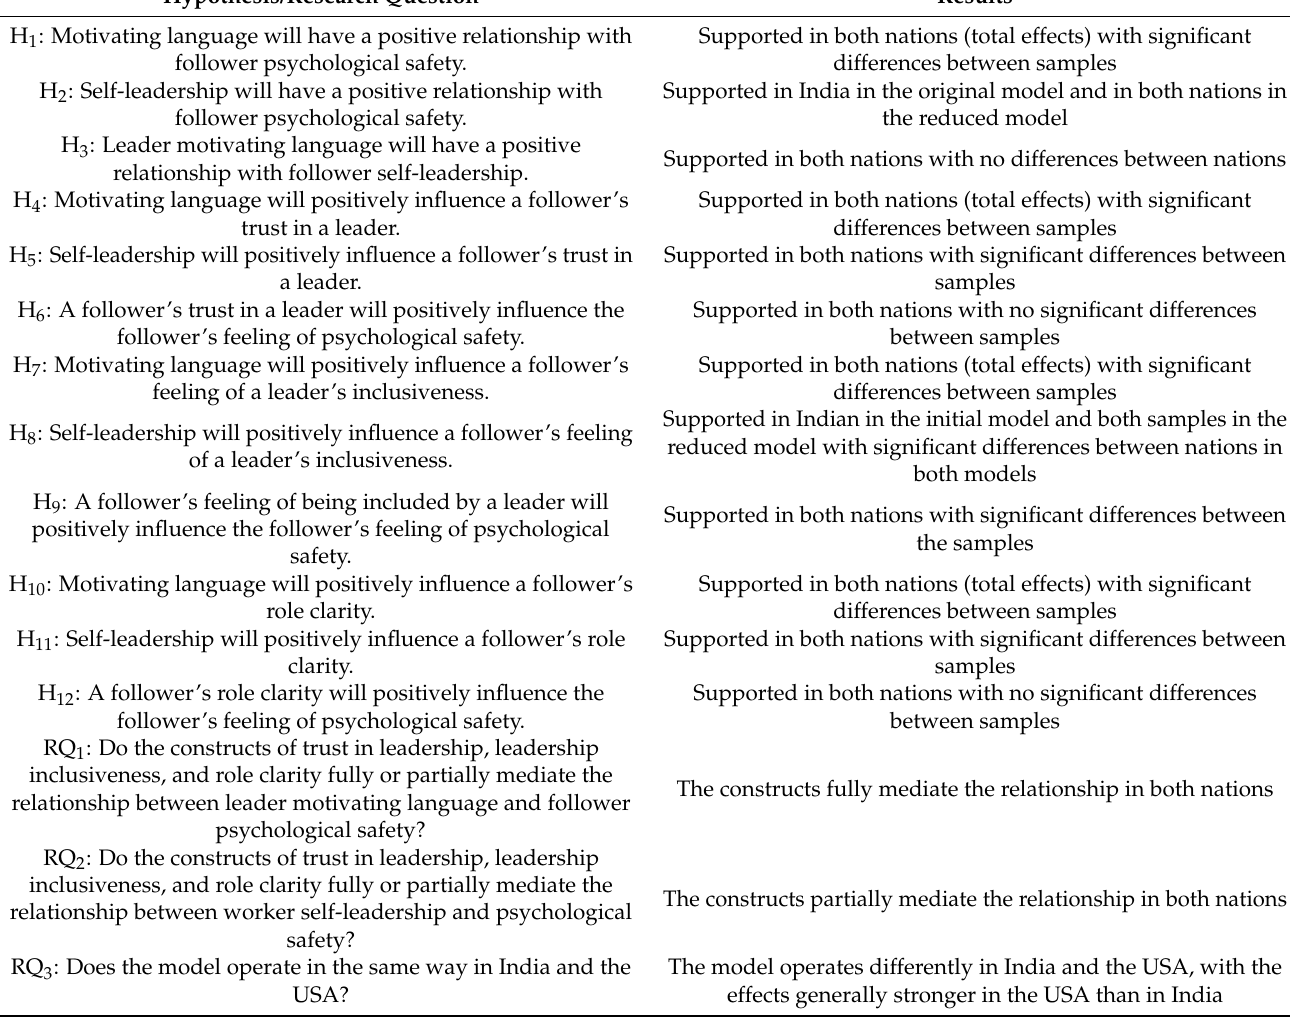
Table 7. Hypotheses and Research Questions, and Model